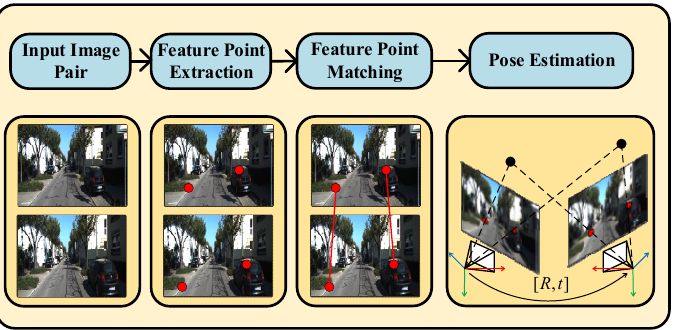
Figure 1. The operating flow of pose estimation in VSLAM. The red points represent the feature points in the images and the black points represent the corresponding 3D points in the real world.